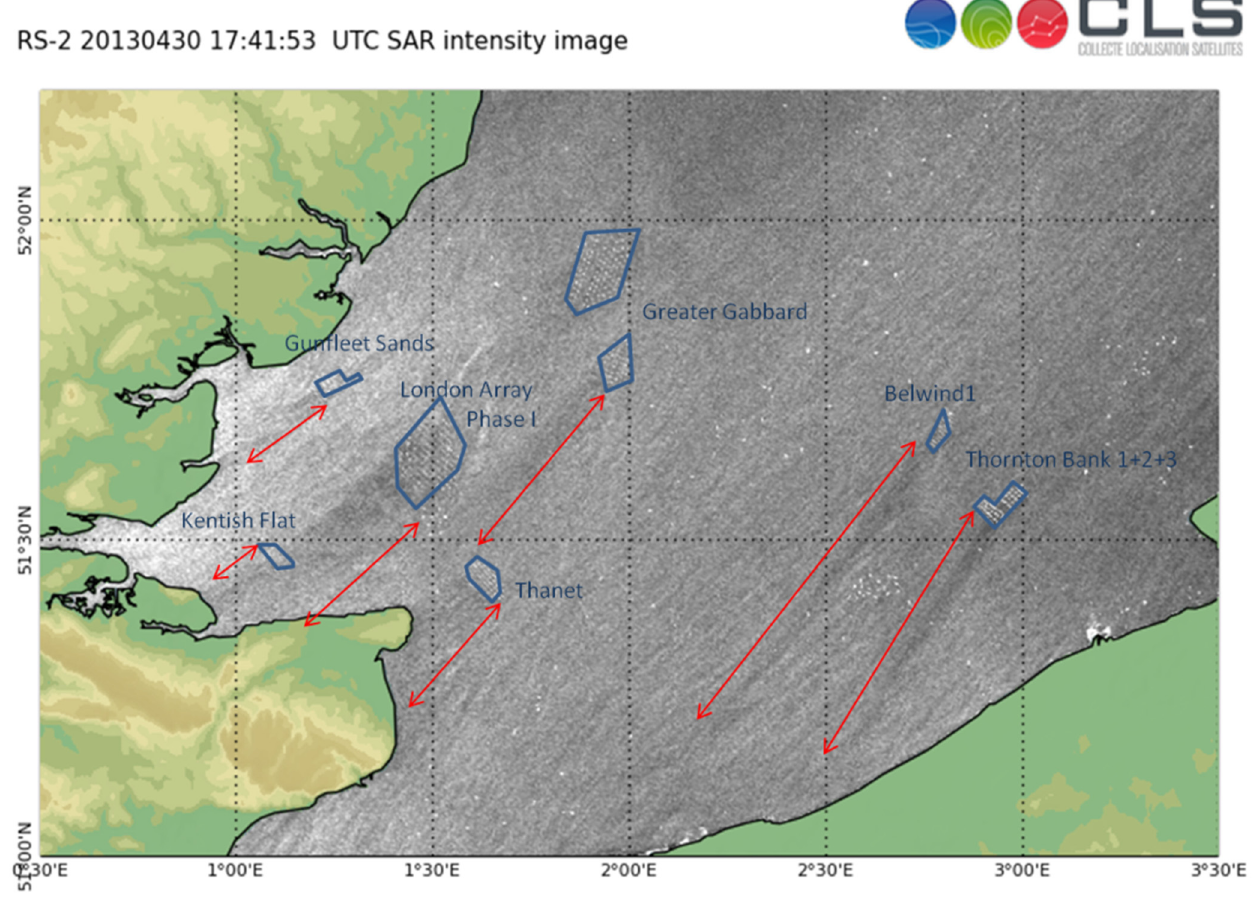
Figure 1. RADARSAT-2 intensity map of the southern North Sea observed 30 April 2013 at 17:41 UTC. The blue lines outline wind farms and the red arrows the wind farm